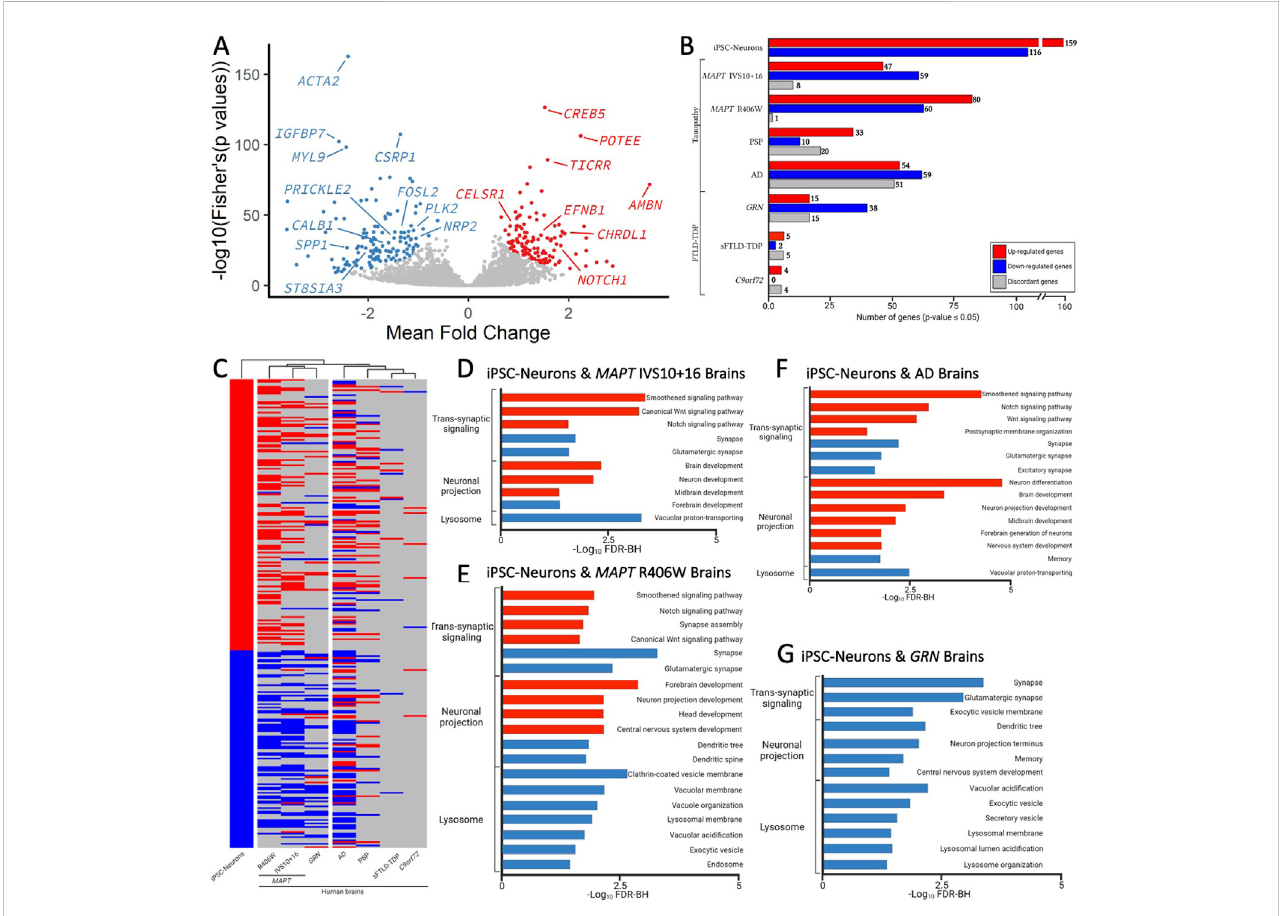
FIGURE 5 Genes changed in iPSC-neurons from MAPT mutations are also altered in brains from tauopathy patients. (A) Meta-Volcano plot identi fi es the common geneexpression changesby MAPT IVS10+16,p.P301Landp.R406W.Red andbluedotsrepresentup-anddown-regulatedgenes,respectively. (B) Bargraph ofthenumberofgenesdifferentiallyexpressed iniPSC-neurons from MAPT mutations(n =275)anddifferentiallyexpressedinbrainsfromtauopathypatients ( MAPT IVS10 + 16 and p.R406W carriers, PSP, and AD) and from FTLD-TDP ( GRN mutation carriers, sporadic FTLD-TDP (sFTLD-TDP), and C9ORF72 expansion carriers). Up-regulated genes, red. Down-regulated genes, blue. Discordant genes (de fi ned as p < 0.05 and logFold change opposite of iPSC- neurons), gray. (C) Heatmapof geneexpressionof 275genesiniPSC-neurons and human brainswith hierarchicalclustering revealingrelatednessofcohorts. (D – F) . Bar graphs showing the most signi fi cant pathways enriched shared between the iPSC-neurons and (D) MAPT IVS10 + 16 brains; (E) MAPT p.R406W brains; (F) sporadic AD brains; (G) GRN mutation carrier brains. Pathways from up-regulated genes (red); pathways from down-regulated genes